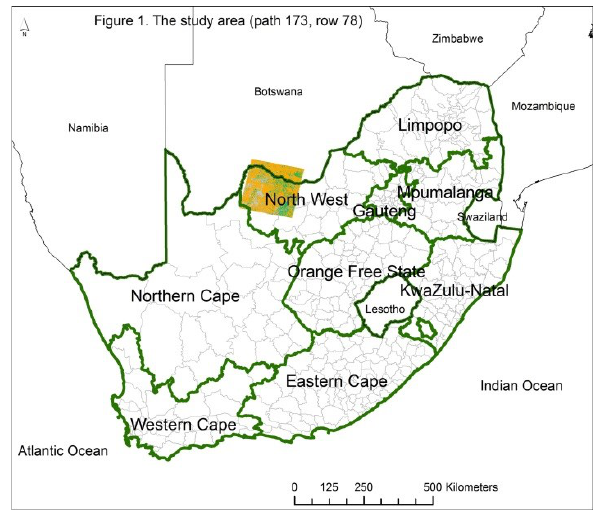
Figure 1. The study area, mainly within the Dr Ruth Segomotsi Mompati District Municipality of the Northwest